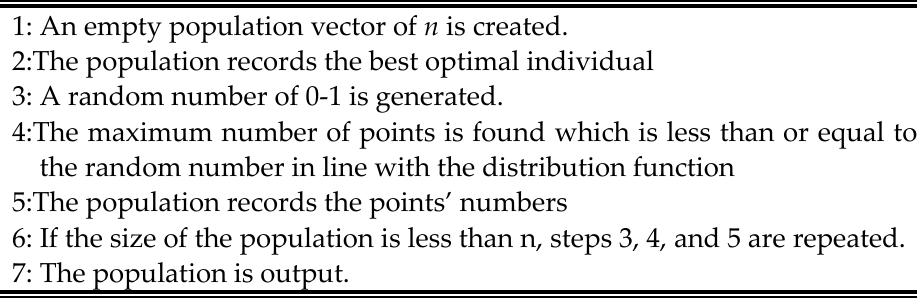
algorithm, crossover operations are performed only on non-optimal individuals in the population. The crossover operator uses the Order Crossover operator. The crossover algorithm is shown in Figure 19, where P c represents the crossover probability.